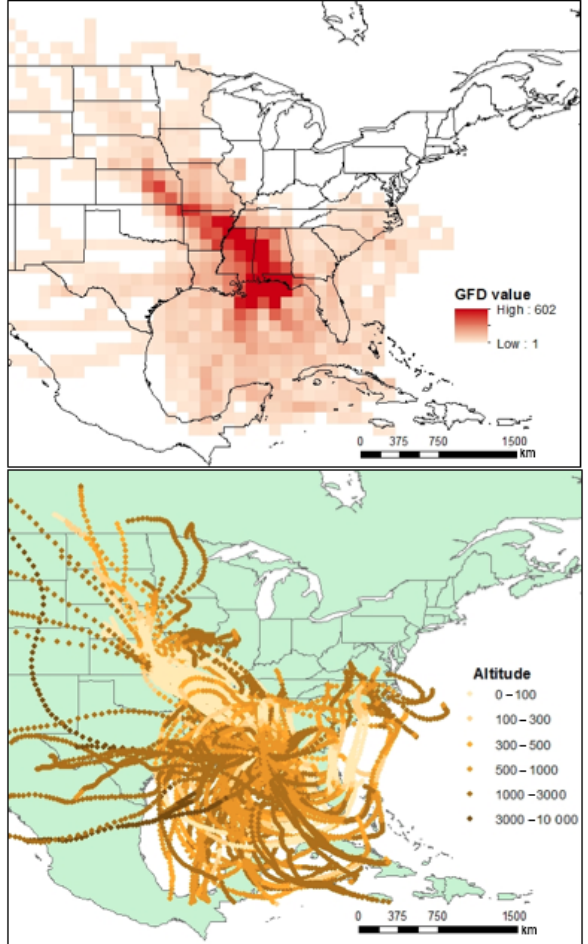
Figure 5. Results of gridded frequency distribution (top panel); light color indicates less endpoints in a grid. Altitude of 72h trajectories (bottom panel) during the polluted event (12 March– 2 April 2013); light color of dots on left panel represents low alti-